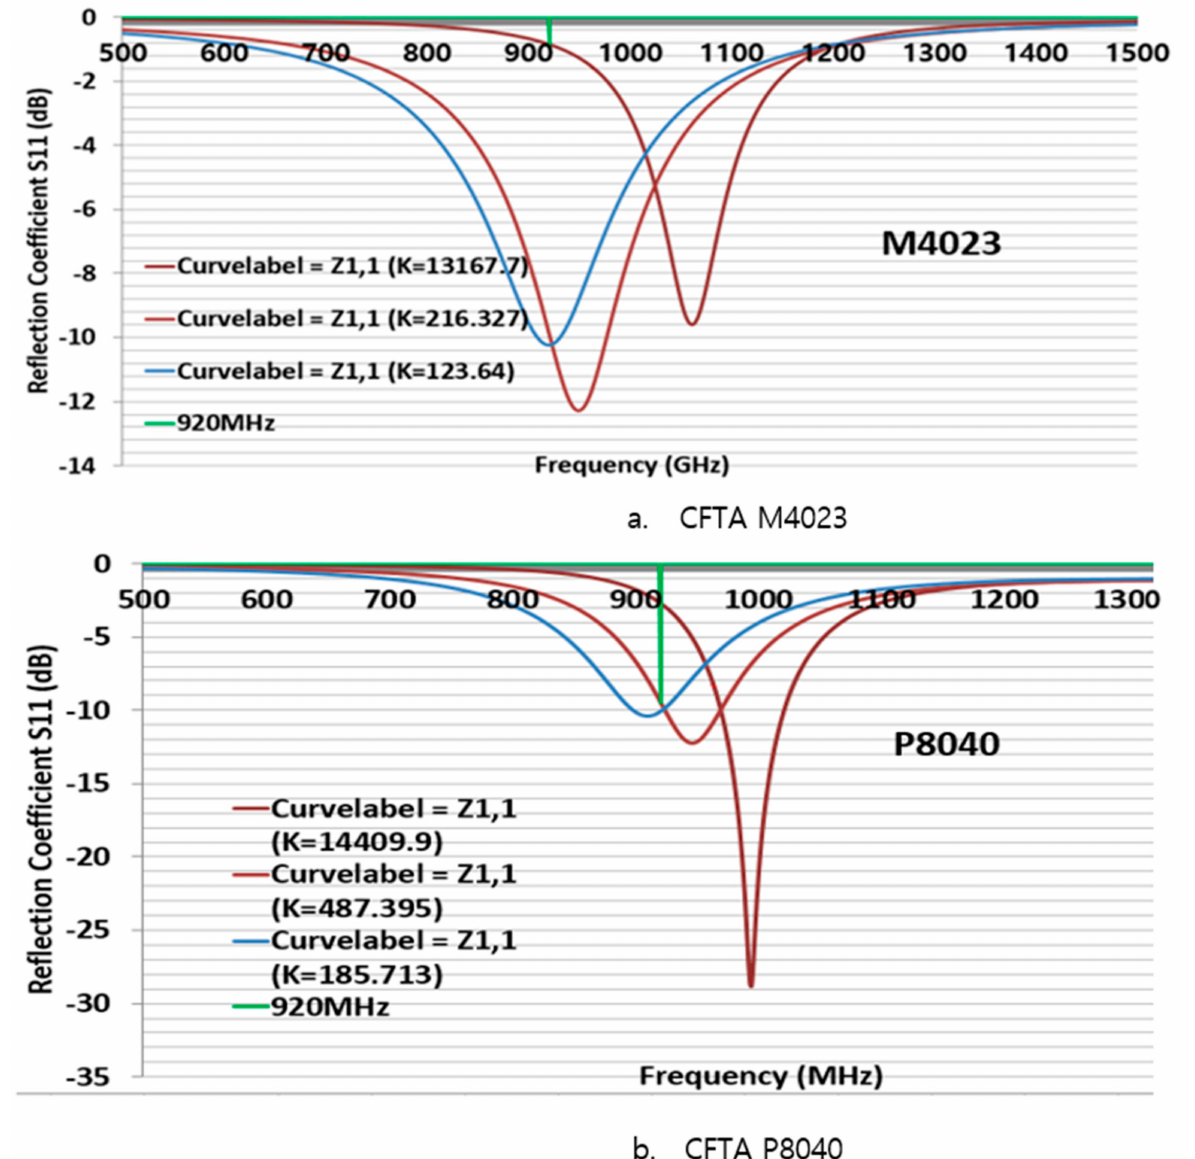
Figure 6. Reflection coefficient S11 comparison by conductivity-K for ( a ) CFTA M4023, ( b ) CFTA